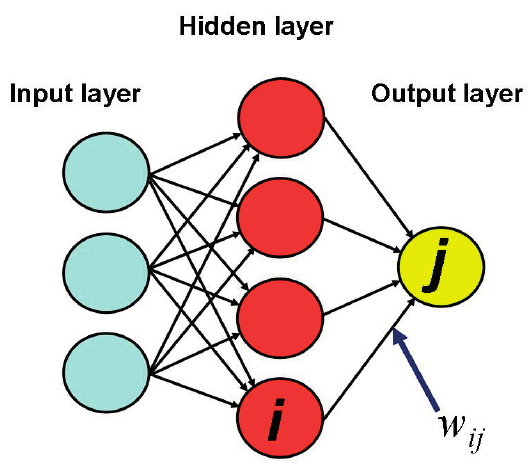
Figure 4. Example of three-layered ANN architecture with one hidden layer. The symbol w ij represents the weight of the connection between the i -th and j -th